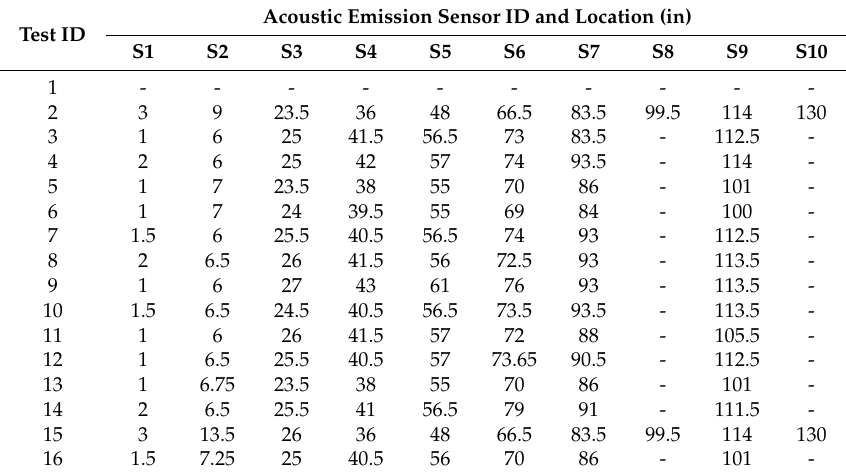
Table 1. Sensor locations along the length of each